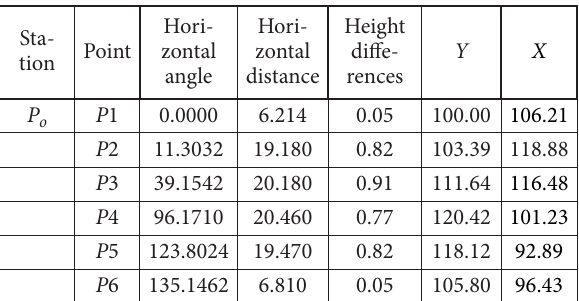
Table 2. The measurement and coordinate values of the corner points which was measured by polar method in an indoor space